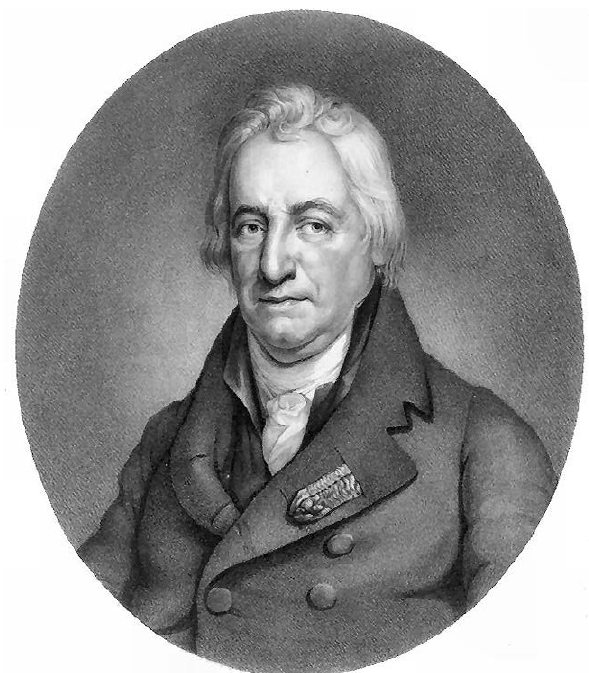
Figure 1. Claude-Louis Berthollet (1748-1822) (Public domain, from reference